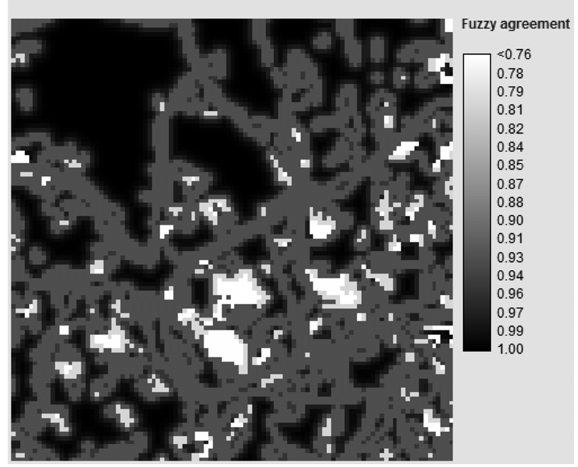
Fig. 5: Fuzzy agreement map for the two land-cover maps